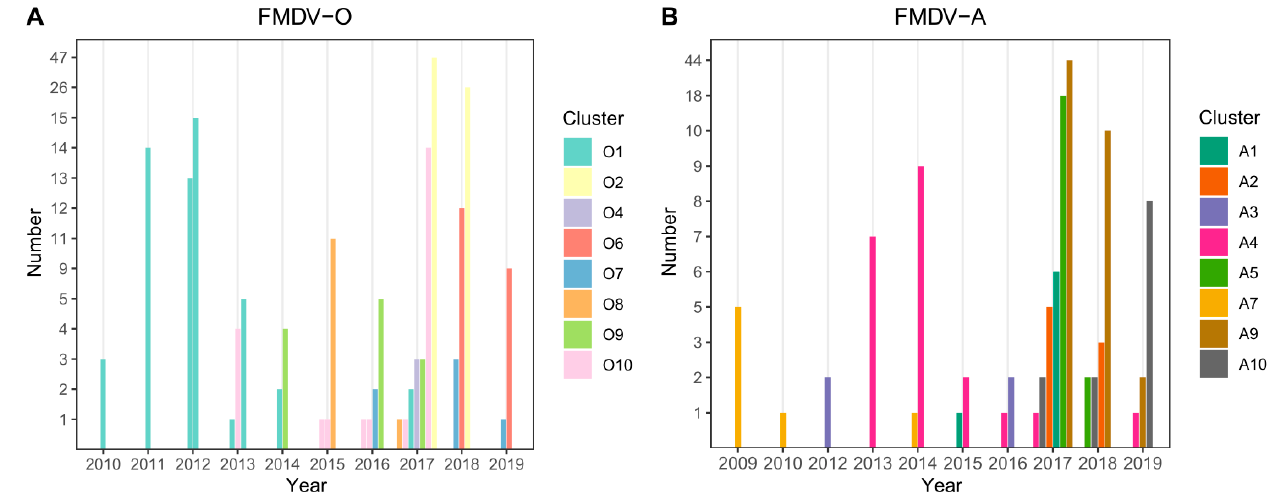
Figure 2. Number of sequences isolated per genetic cluster per year for ( A ) serotype O and ( B ) serotype A from years 2010 through 2019. Serotype O clusters O-6 and O-9 belonged to the SEA/Mya-98 lineage, cluster O-7 to the Cathay lineage, O-8 belonged to ME-SA/Ind2001d and all the other clusters belonged to the O/ME-SA/Pan Asia lineage. All serotype A clusters belonged to the Sea/97 lineage.